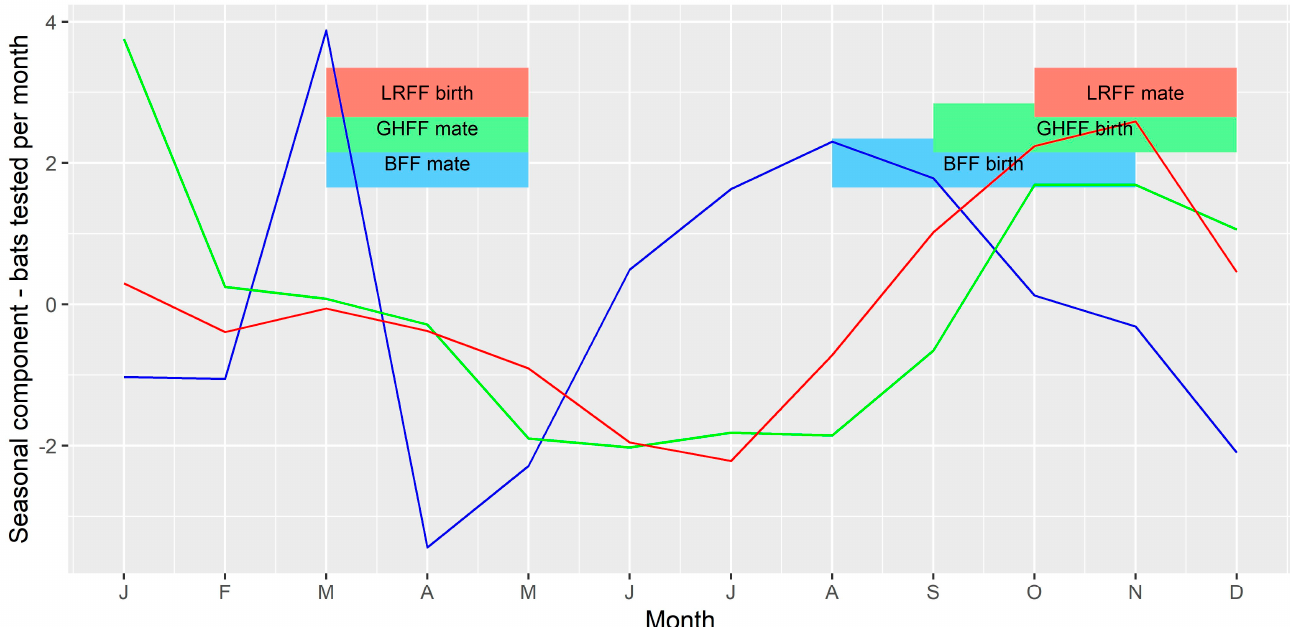
Figure 7. Seasonal component of time series of bats tested per month. The vertical axis represents the expected increase or decrease in number of submissions in each month. Blue = BFF; green = GHFF; red = LRFF.